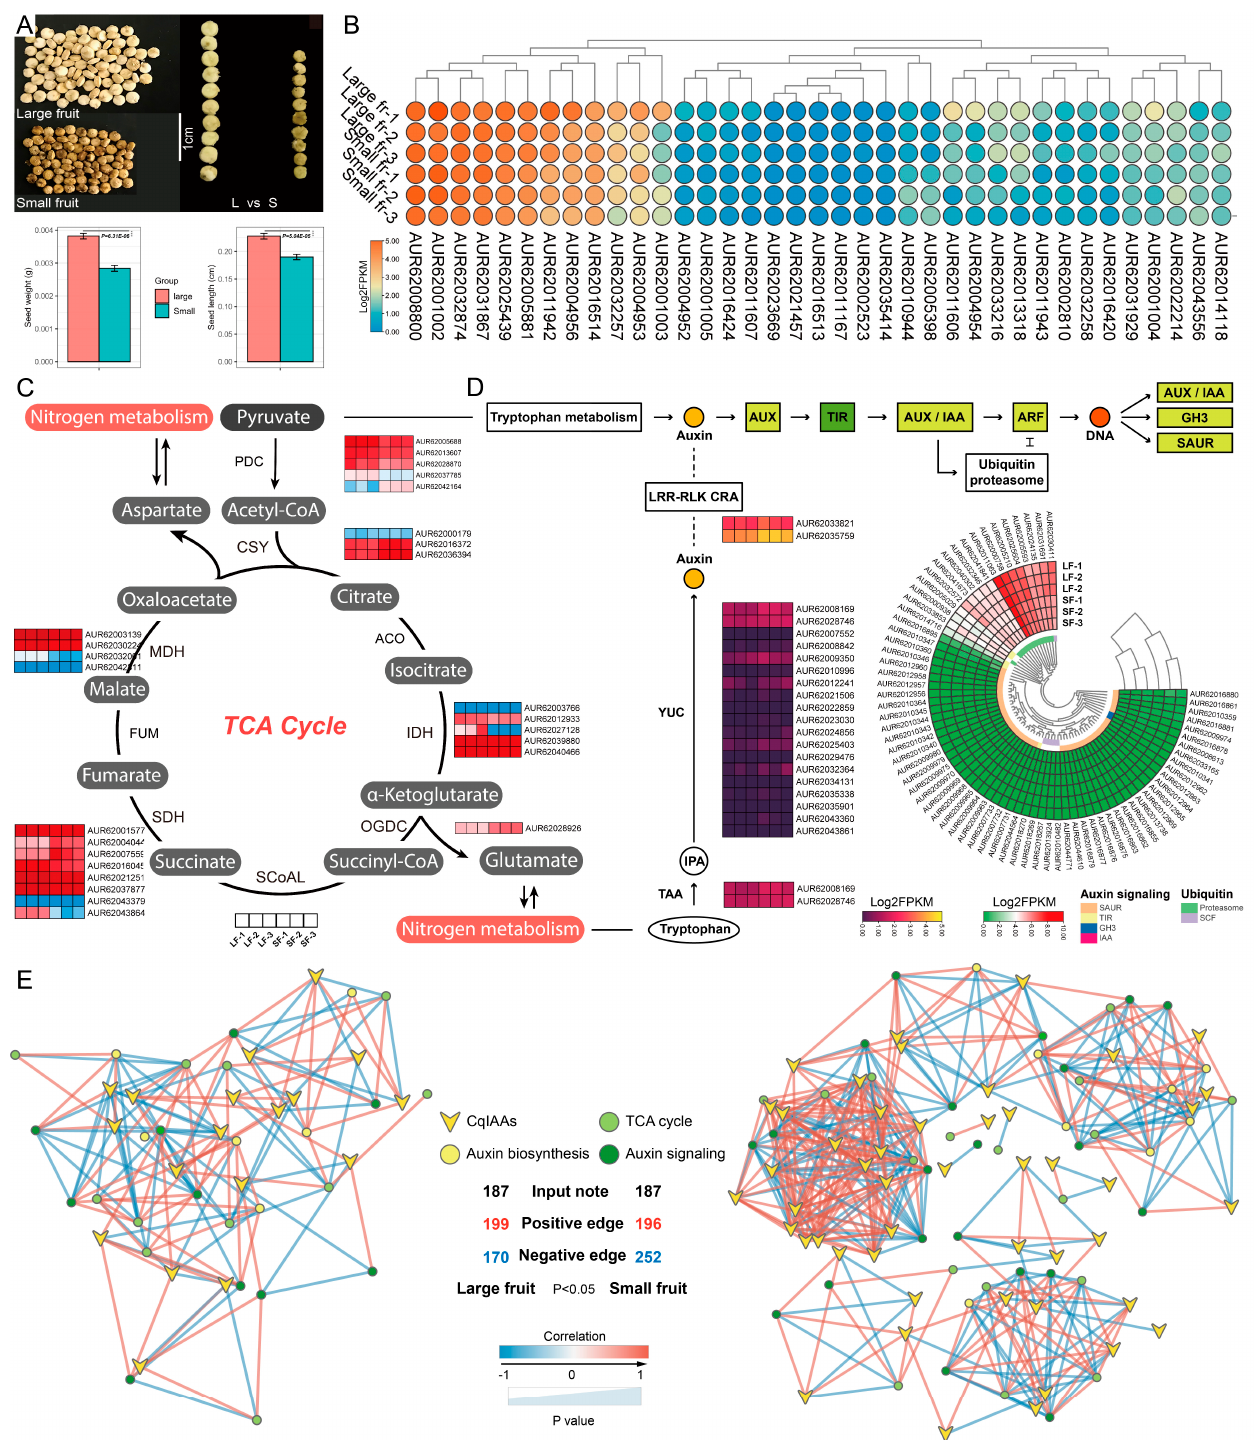
Figure 5. Morphological display, differential expression of CqIAAs , differential expression of auxin signaling and energy metabolism pathway and sexual network with CqIAAs. ( A ). Morphological presentation and data comparison of quinoa with different seed sizes and colors. ( B ). Expression pro- files of 37 CqIAAs in two quinoa seeds. According to the expression quantity (FPKM), the heat map is clustered (expression data are recorded in Table S11); ( C ). Expression profiles of TCA cycle pathway genes in two quinoa seeds (expression data are recorded in Table S12); ( D ). Expression profiles of auxin biosynthesis and signal transduction pathway genes in two quinoa seeds (expression data are recorded in Table S12); ( E ). Correlation network between CqIAAs and different pathway